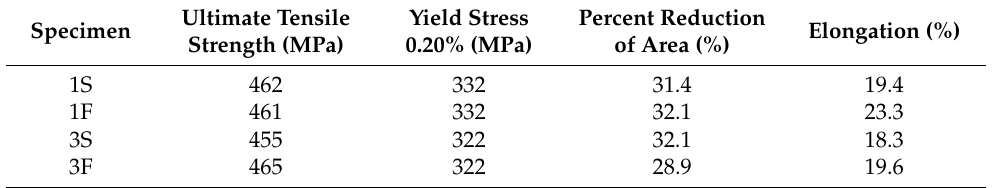
Table 9. Results for the mechanical properties obtained by uniaxial tensile tests (average values).